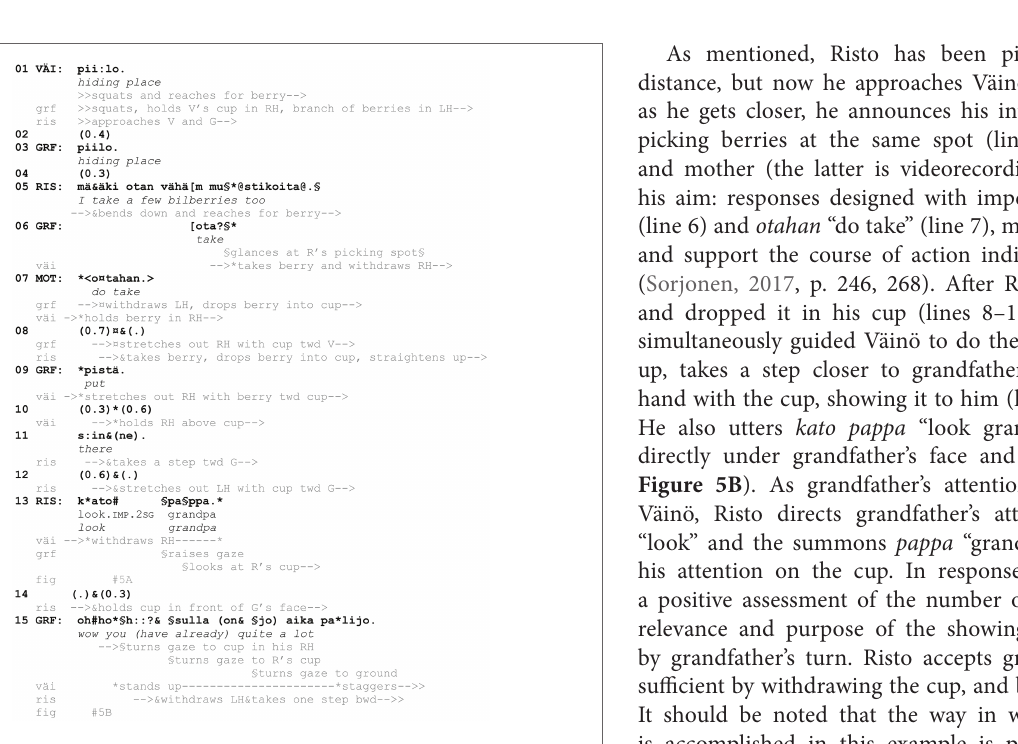
FIGURE 4 | Anni walks along the path, holding the berries in her left hand; father is bending down to reach for berries with his right hand (A) . Anni is quite far away from father as she initiates the kato turn; father looks downward and orients to picking berries (B) . Anni stops in front of father, looking at him and holding the berries in her outstretched hand; father looks at the berries (C) . Anni looks downward and bends sideways to drop berries into father’s bucket; father looks at the berries (D)